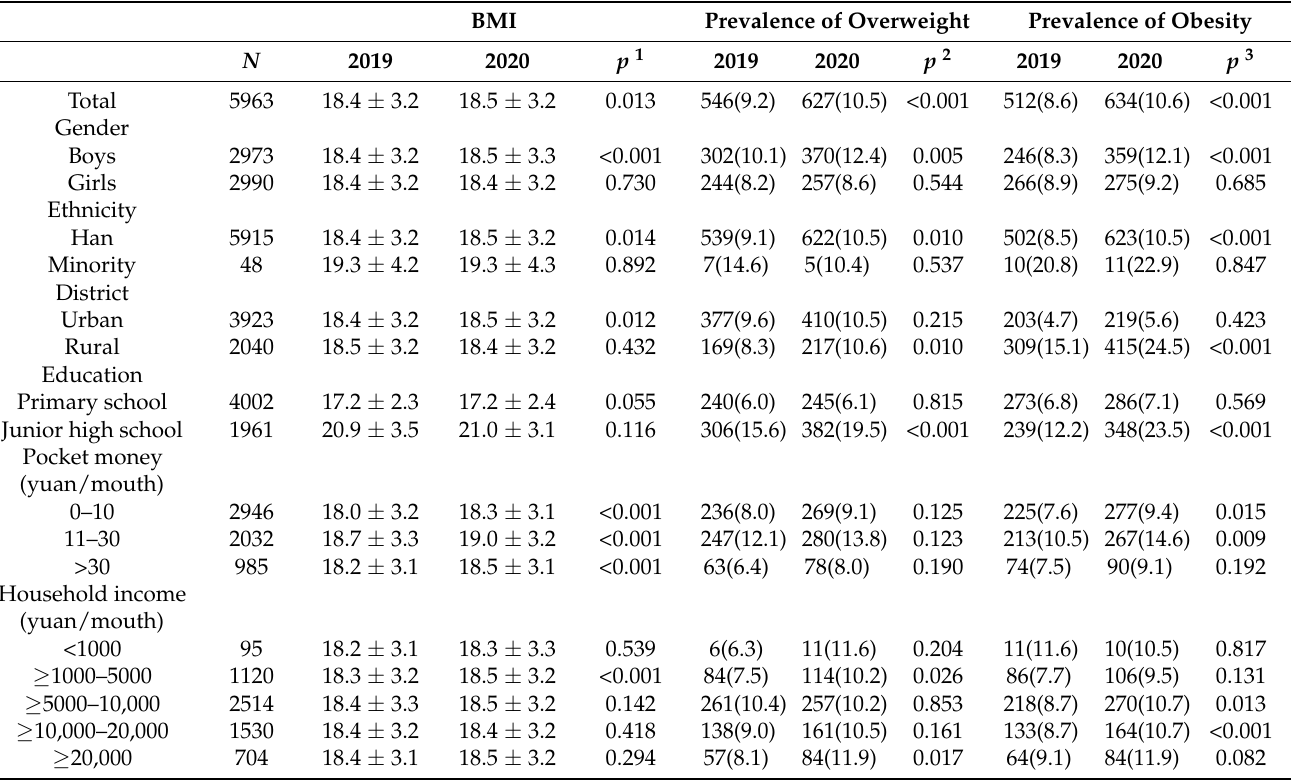
Table 2. Changes in weight status of children before and during the